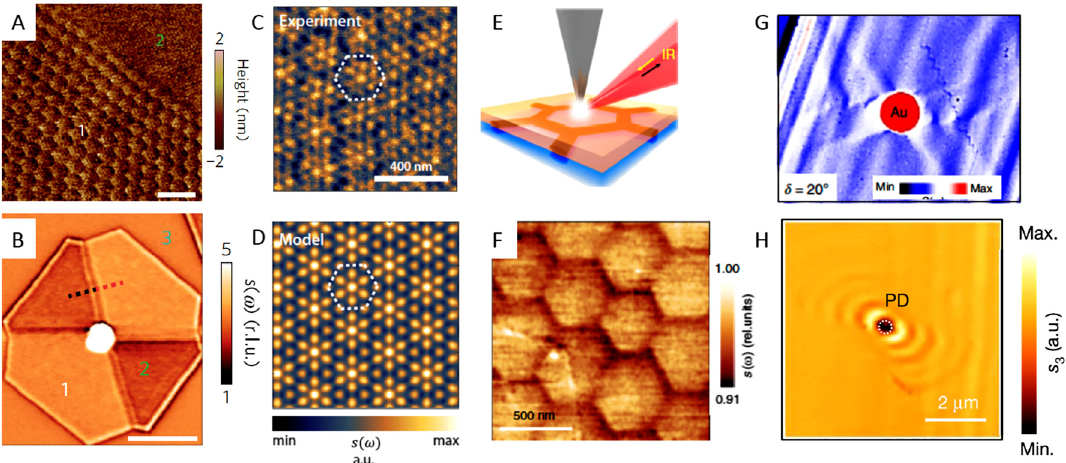
Figure 6: Moire polaritons and topological phonon polaritons in twisted van der Waals materials. Panel A: atomic force friction image of the graphene/hBN structure at the boundary between the moir ´ e-superlattice and plain graphene (markedinPanelB).Moirereconstructionleadstoaperiodicpatternwiththeperiodicityof14nm.Scalebar1 μ m.PanelB:nanoinfraredimage of the graphene/hBN structure. Darker contrast occurs in the moire region. The analysis of plasmon polariton fringes along the boundary between moire superlattice and plain graphene allows one to reconstruct the gross feature of the altered electronic structure in the moire superlatticeregion.AdaptedfromastudybyNietal.[255].PanelC:nanoinfraredimageofplasmonpolaritonsinterferencepatternsinamoir ´ e superlatticeformedbytwistedlayersofgraphene.The dashedhexagonsrepresenttheboundariesof